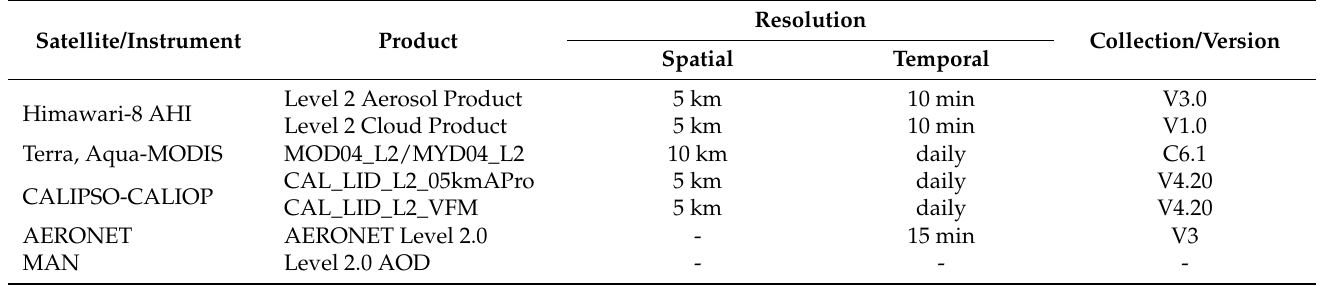
Table 1. Information of datasets used in this